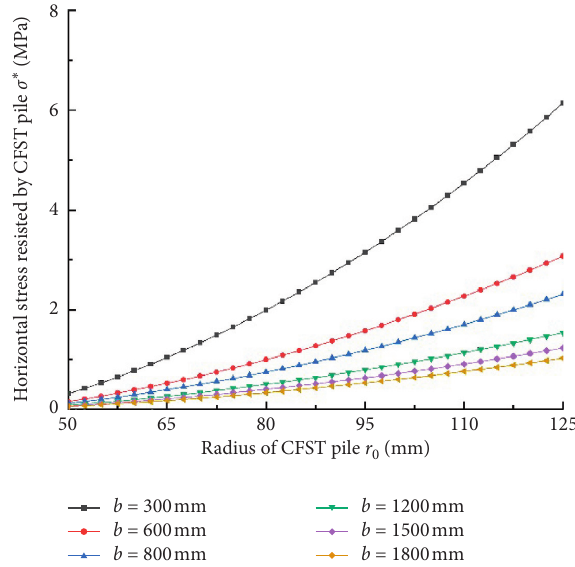
Figure 9: Influence of supporting parameters on stress resistance.